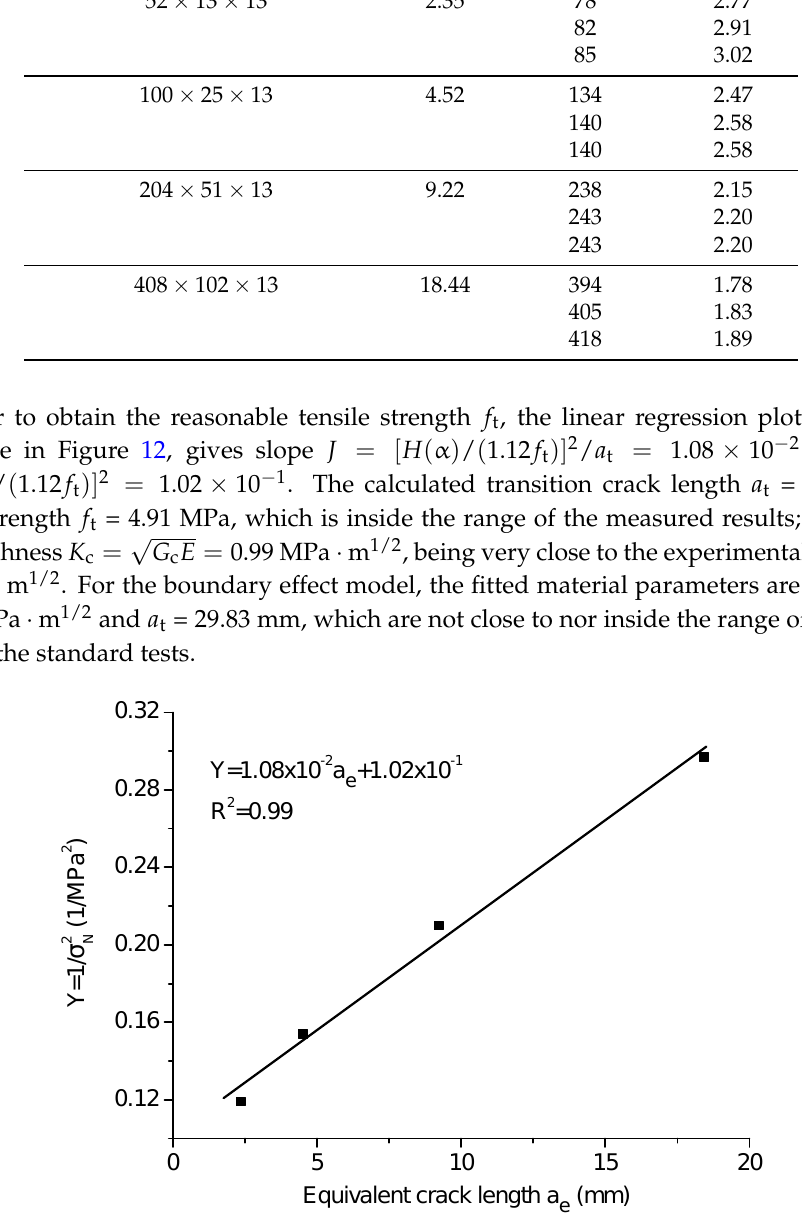
Figure 12. Linear regression on the test results of